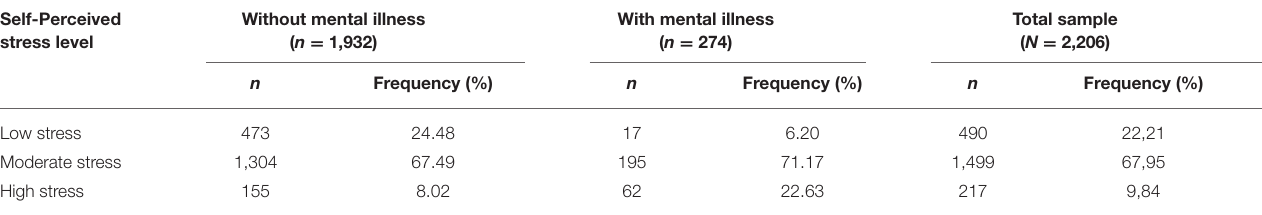
TABLE 3 | Self-Perceived stress levels in the sample.